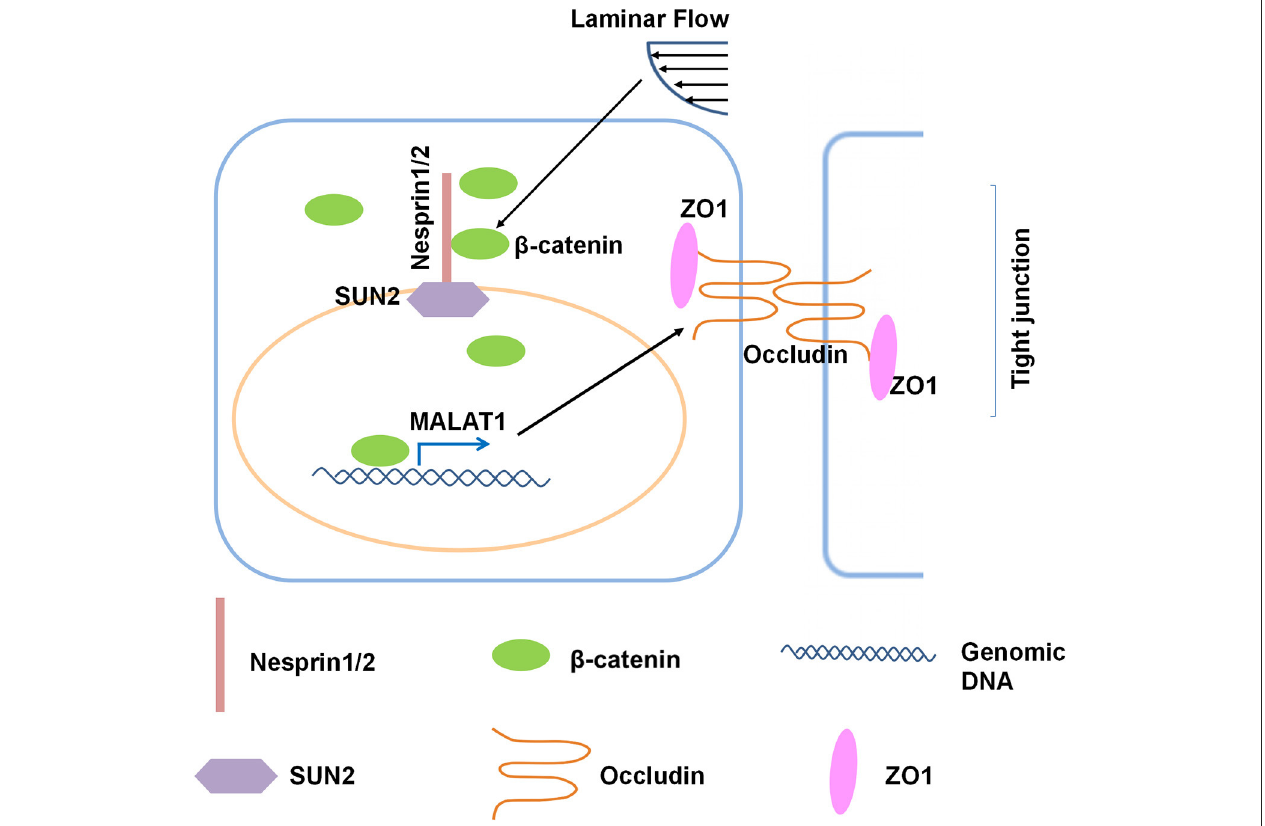
FIGURE 8 | Schematic diagram of the mechanism that mediates the laminar flow-regulated endothelial tight junction and barrier function. Laminar flow enhances the physical interaction between β -catenin and Nesprin1 and the association of Nesprin1 with SUN2 at the nuclear envelopes to facilitate the nuclear translocation of β -catenin. β -catenin activates MALAT1 expression in the nucleus, thereby promoting the expressions of tight junction proteins ZO1 and